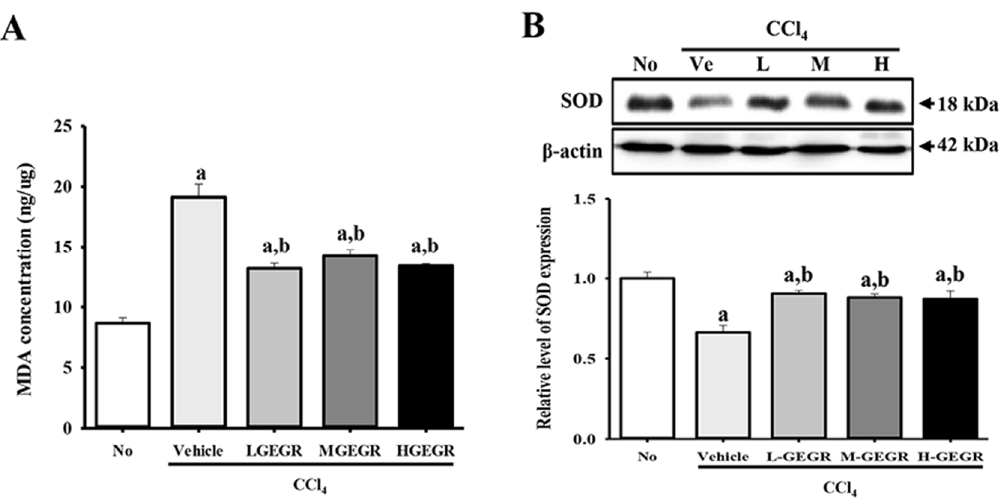
Figure 4. Alteration of oxidant stress related factors. ( A ) The level of MDA was determined in serum collected from mice using a lipid peroxidation assay kit that could detect MDA at 0.1 nmole/mg to 20 nmole/mg; ( B ) The expression level of SOD was measured in the homogenate of liver tissue collected from subset groups. The intensity of each band was determined using an imaging densitometer and the relative level of each protein was calculated based on the intensity of actin protein as an endogenous control. Data represent the means ± SD of three replicates. a, p < 0.05 compared to the no treatment group; b, p < 0.05 compared to the vehicle/CCl 4 treated group.